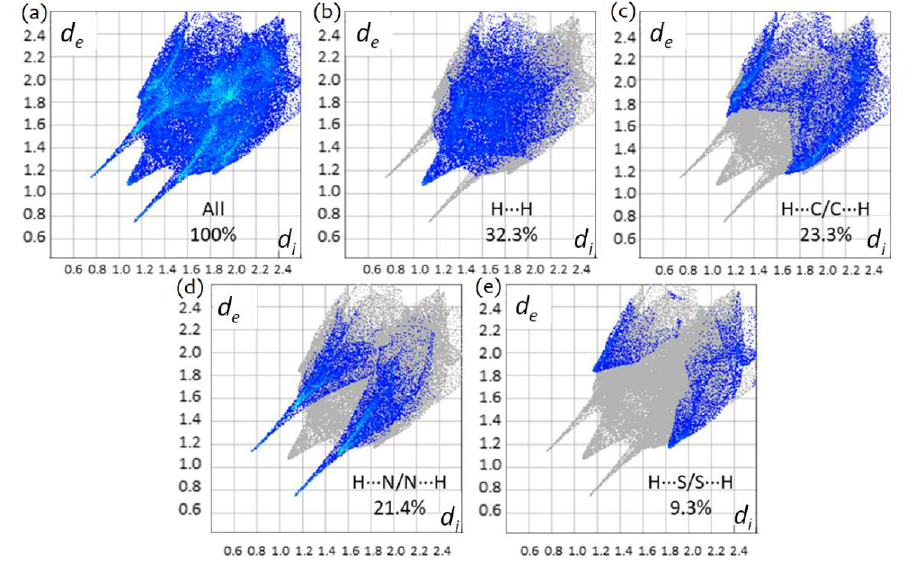
Figure 11. The two-dimensional fingerprint plots for TBZ, showing ( a ) all interactions, ( b ) H ... H, ( c ) H ... C / C ... H, ( d ) H ... N / N ... H and ( e ) H ... S / S ... H interactions. Colored areas represent the contributions of atoms within specific interacting pairs, while the grey areas are a representation of the totality of interactions. Colors are determined by the fraction of surface points in 0.01 Å bin in both d e and d i . Actual colors span a continuous range, and are mapped using the HSV (Hue, Saturation, Value) scheme, where S ≈ V ≈ 1.0, and H ~ 0.66 (240°, blue) for minimum relative area, and H ≈ 0.0 (0°, red) for more than 0.1% of surface points in the bin.